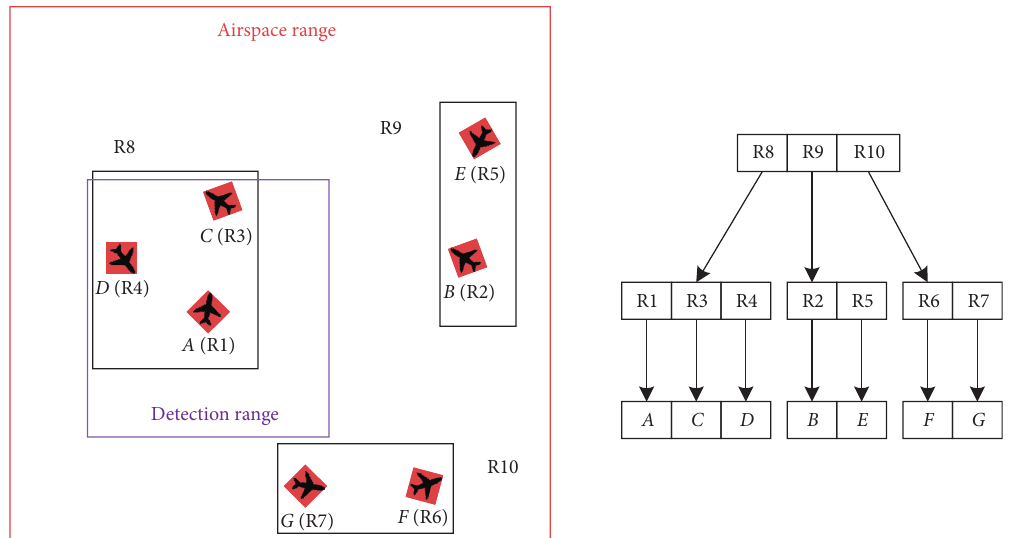
Figure 3: Schematic diagram of conflict detection based on R tree: R1-R7 are the MBRs of aircraft (A–G).